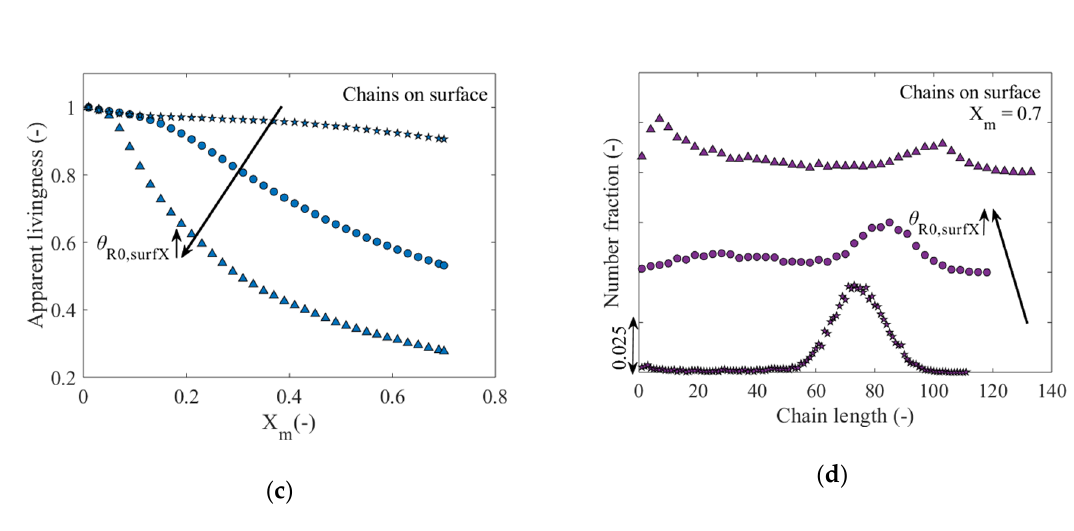
Figure 9a evaluates the effect of (cid:2016)